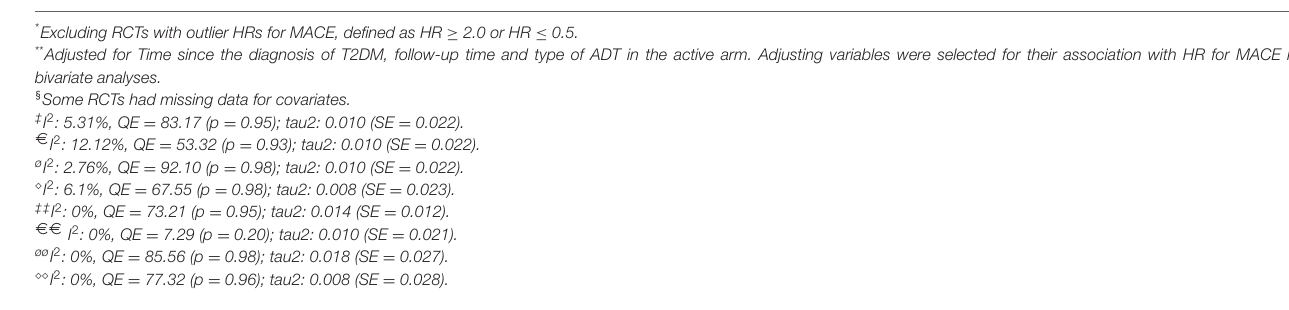
TABLE 2 | Bivariate and multivariate meta-regression models with the hazard ratio for major adverse cardiovascular events (MACE) as dependent variable. Bivariate